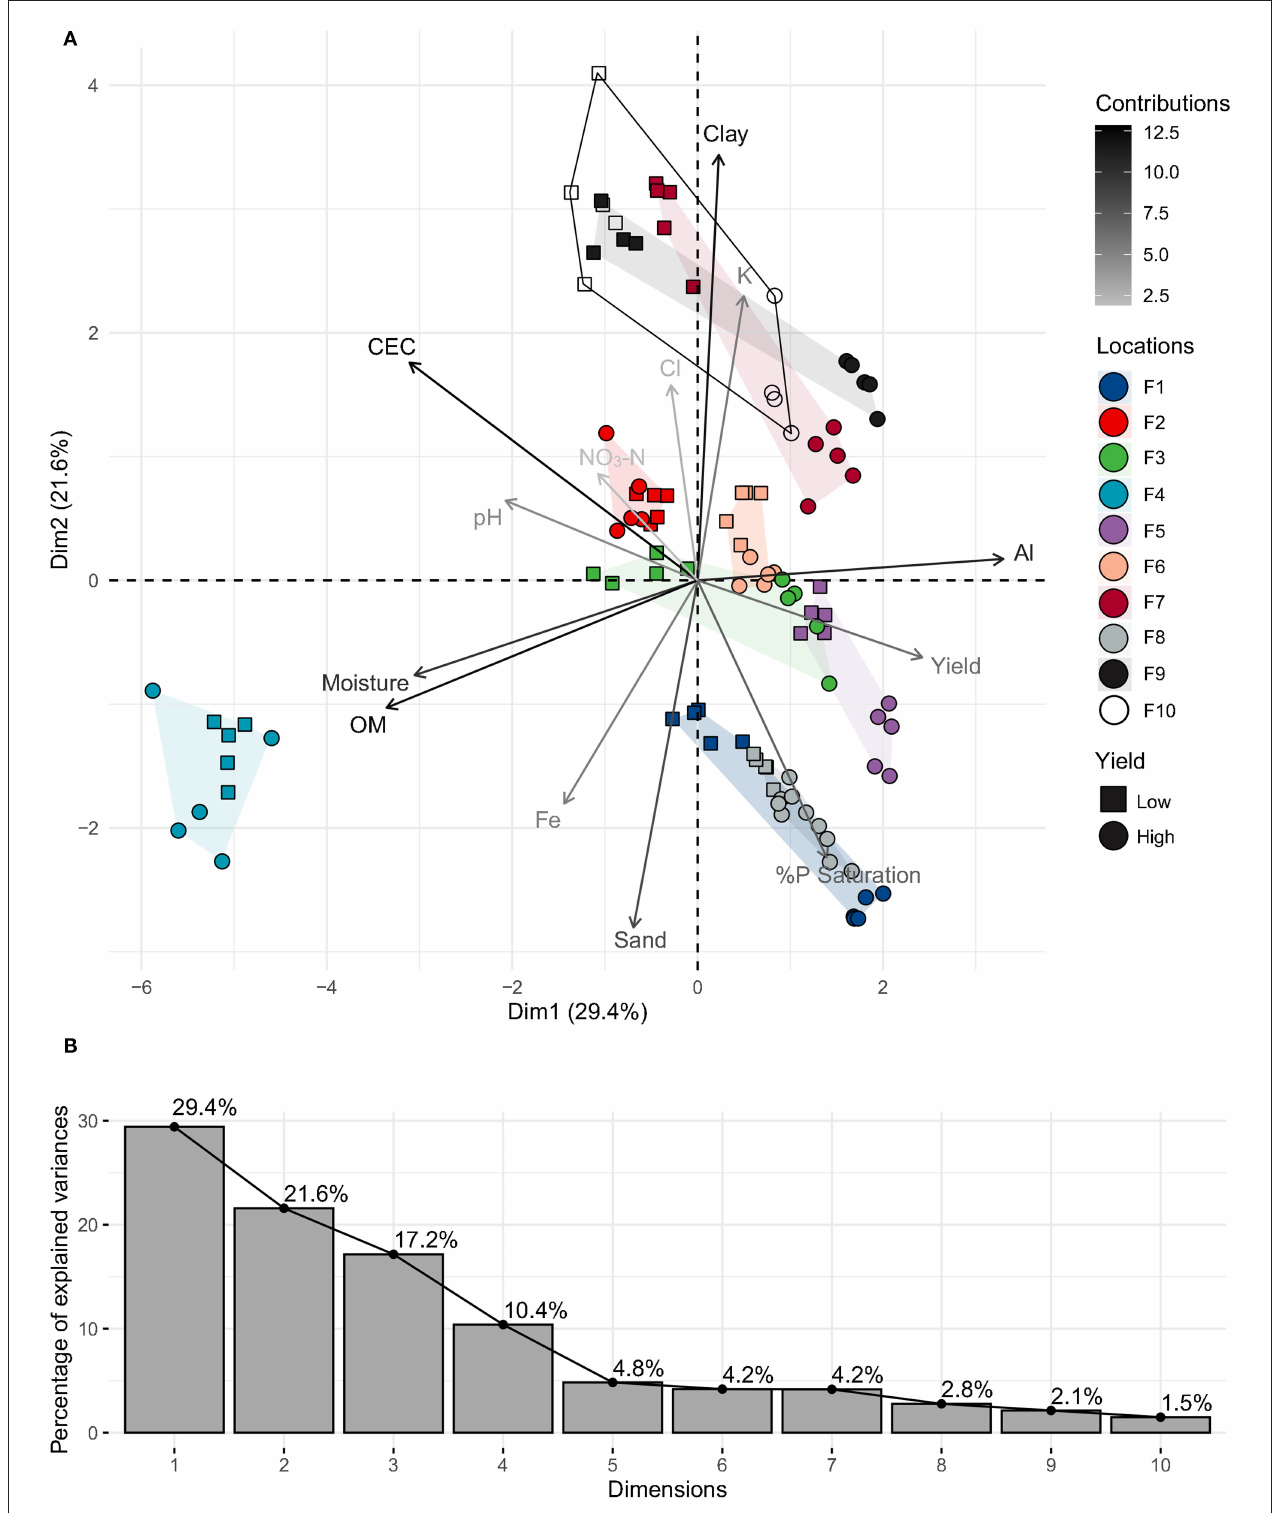
FIGURE 2 | (A) PCA plot of key soil rhizosphere physicochemical factors from low and high yield sites on all farms (1–10). Variable vectors are colored by the strength of their contributions (cos2 value); (B) Scree plot of percentages of explained variances by PCA dimensions.